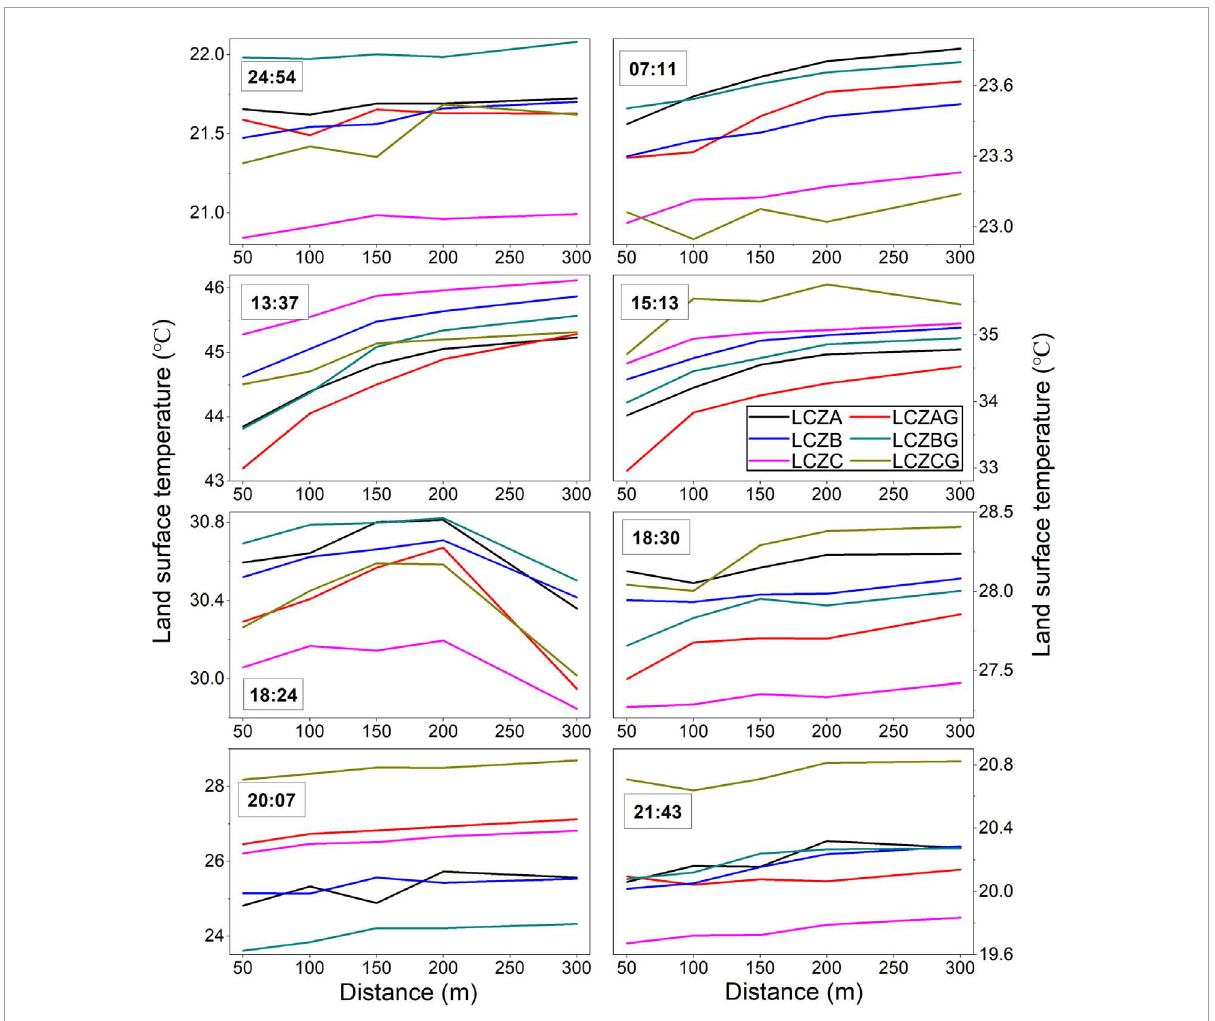
FIGURE7 The mean land surface temperature round each park at different distances. The x axes present the distance from the regions to parks, e.g., 50 presents 0–50 m, 100 presents 50–100